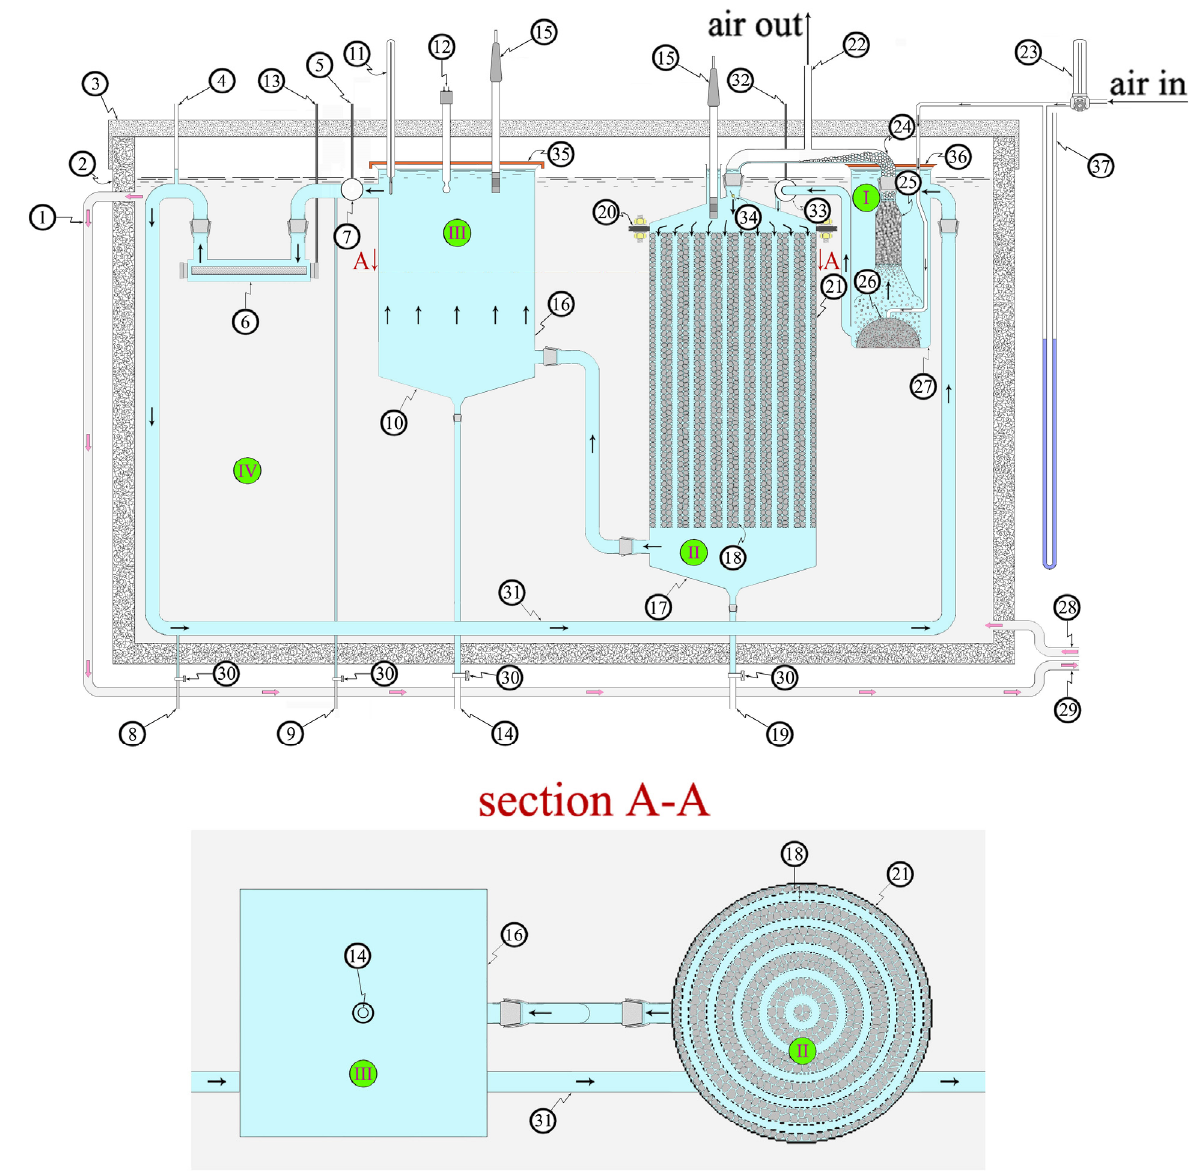
Figure 1. Schematic view, not to scale, of the biodegradation experimental apparatus the BIOmini-MODUS .